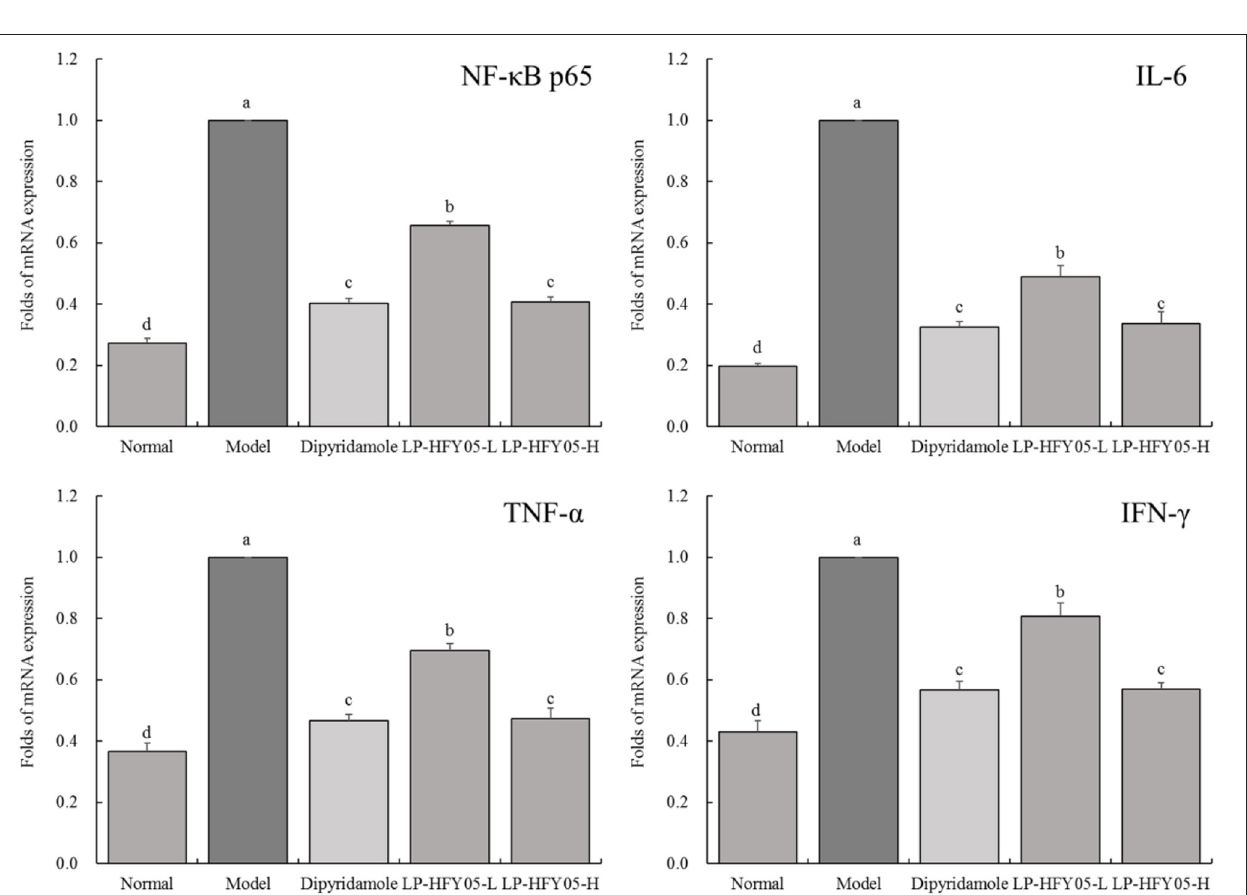
FIGURE 6 | mRNA expression of NF- κ B p65, IL-6, TNF- α , and IFN- γ in renal tissues of mice with thrombosis. a − d Mean values with different letters in the different bars were significantly different ( P < 0.05) according to the SNK multiple-range test; b, c, and d indicate significance vs the model group; the same letter of c indicates that there was no significant difference ( P > 0.05) between the two